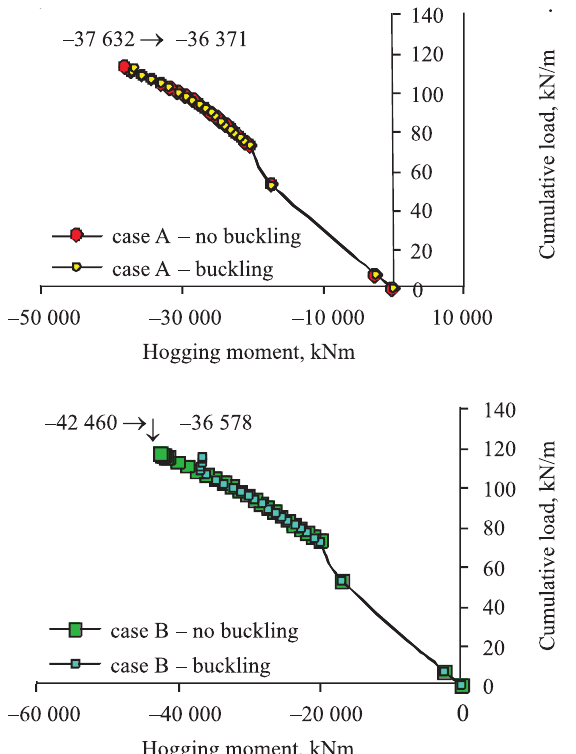
Fig. 16. H3 case B without buckling (a) and H3 case B with